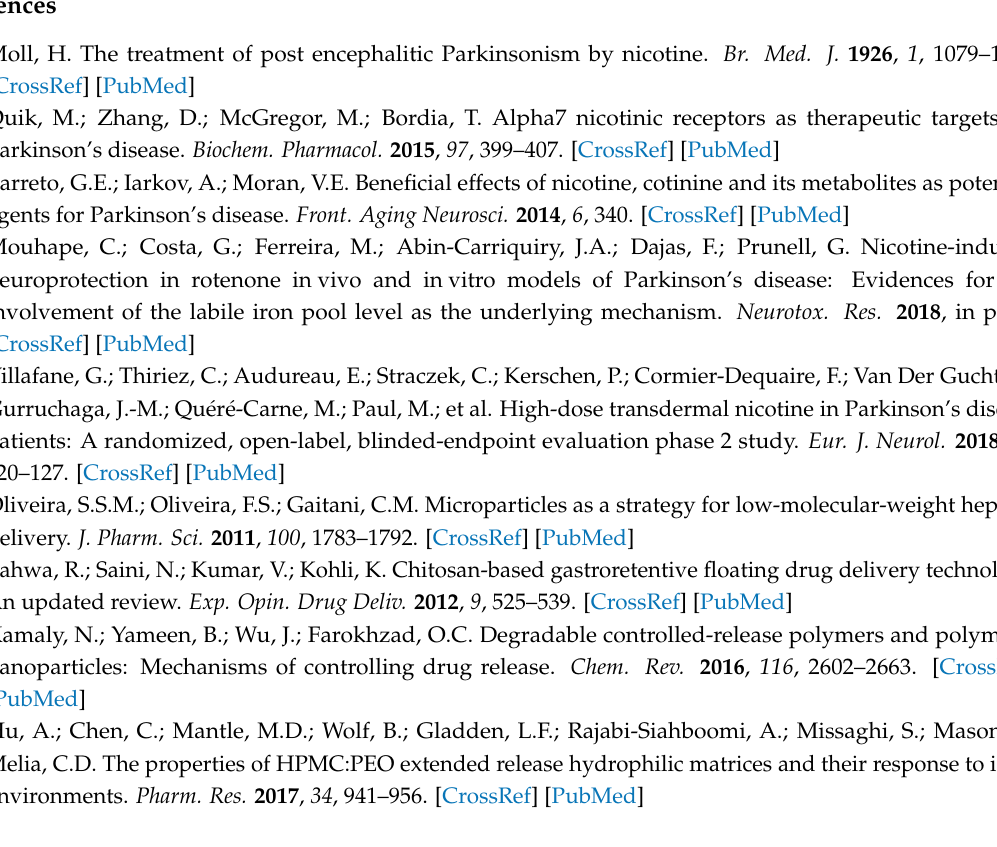
Figure S1: Image processing of micrograph of a PLGA scaffold: ( a ) BLURimage: blurred SEMimage; ( b ) CQimage: colorquantized image of BLURimage; ( c ) UniHisto: uniform histogram of CQimage; ( d ) UniHistoSep: separated uniform histogram of CQimage after image processing; ( e ) NonUniHisto: non-uniform histogram of SEMimage before image processing; and ( f ) NonUniHistoSep: separated non-uniform histogram of SEMimage before image processing. Note that each color channel is only capable of highlighting most of the pores, but not